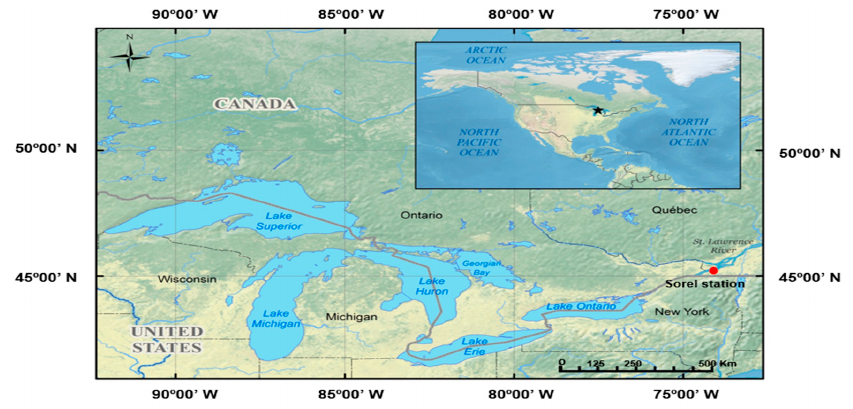
Figure 1. Great Lakes and St. Lawrence River location. The water levels in the St. Lawrence are gauging at Sorel Station.